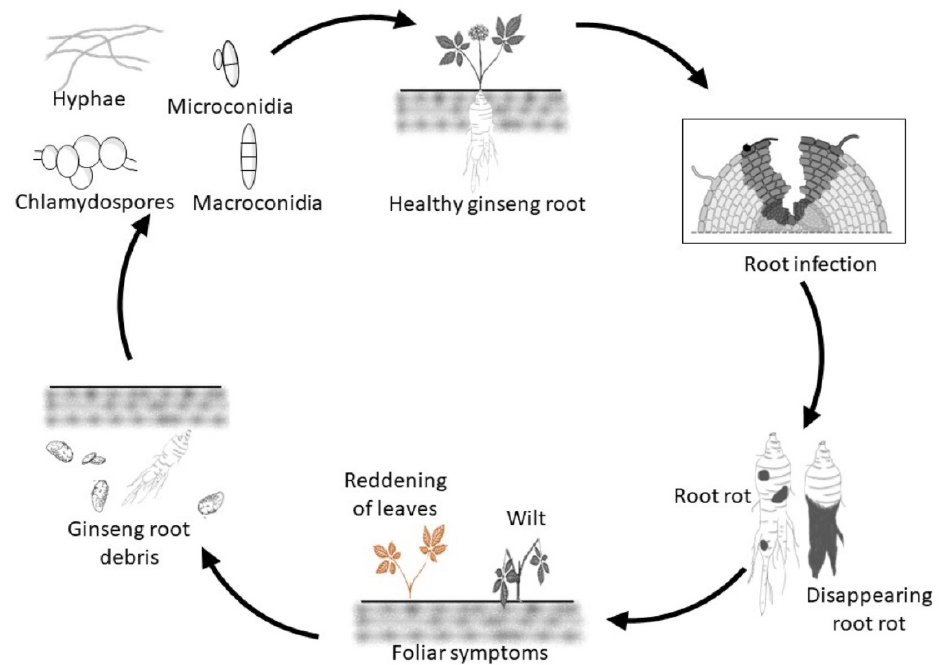
Figure 1. Cylindrocarpon / Ilyonectria spp. disease cycle on ginseng. Illustration created with BioRender [18].